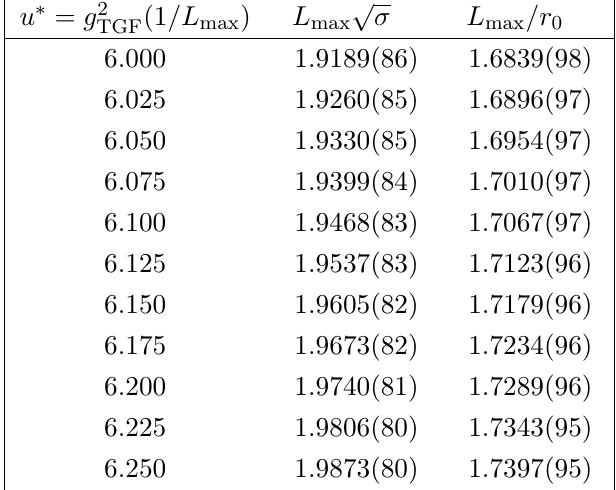
p Table 7 . L max (cid:27) and L max =r 0 for each u (cid:3) in the continuum